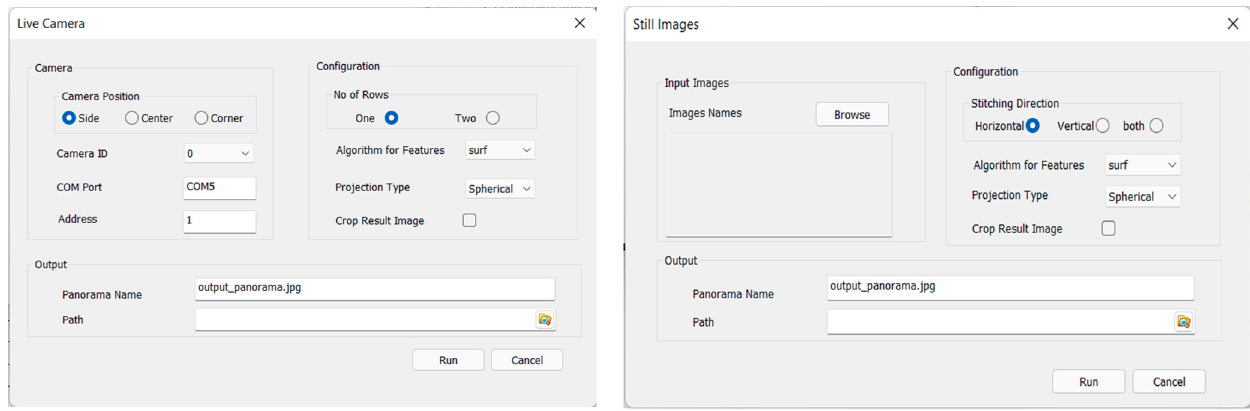
Figure 8. Graphical user interface of PTZ panorama application.